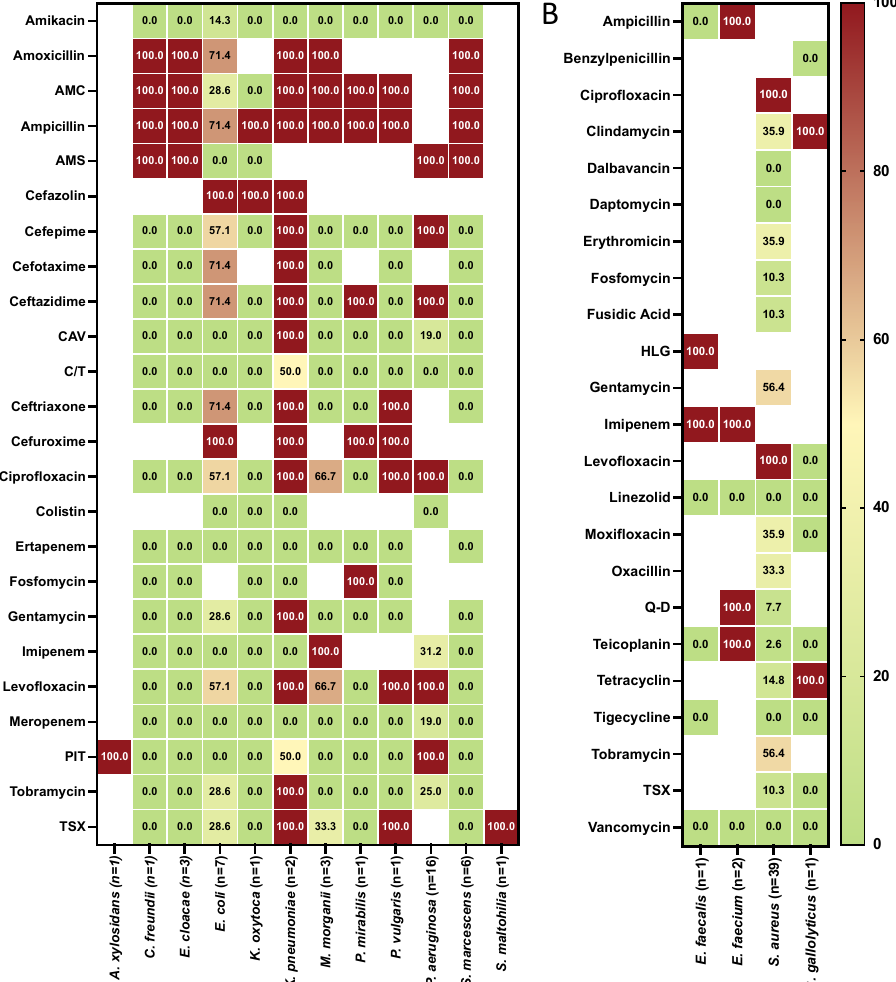
Figure 1. Antibiotic resistance pattern (% of resistance) for the indicated antibiotics tested against the Gram-negative ( A ) and Gram-positive ( B ) pathogens isolated from 56 patients with infected chronic venous leg ulcers. The numbers in brackets indicate the number of bacterial isolates. Isolates were classified as susceptible or resistant according to the European Committee on Antimicrobial Susceptibility Testing clinical breakpoint tables (EUCAST clinical breakpoint). Blank: not tested. (AMC) amoxicillin/clavulanic acid; (AMS) ampicillin-sulbactam; (CAV) ceftazidime-avibactam; (C/T) ceftolozane/tazobactam; (HLG) high-level gentamicin; (PIT) piperacillin/tazobactam; (Q-D) quinupristin-dalfopristin (TSX) trimethoprim/sulfamethoxazole. Fluorescence microscopy analysis of S. aureus , P. aeruginosa, and E. coli, classified as SBP (Figure 2B), showed the presence of a uniform layer of mature biofilm ranging from Of the 89 isolates, 25.8% ( n = 23) were classified as MDROs including methicillin- 20 to 60 μ m with different morphologies after 24 h of incubation. resistant S. aureus (MRSA) ( n = 13), multidrug-resistant P. aeruginosa ( n = 4), extended- spectrum β -lactamase (ESBL)-producing E. coli ( n = 5) and S. maltophilia resistance to